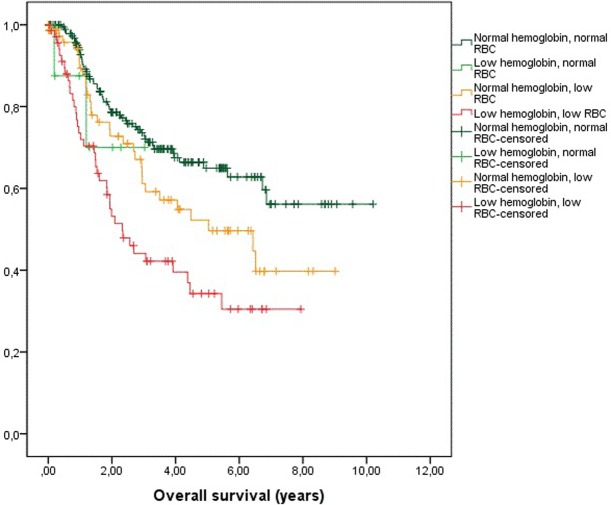
Kaplan-Meier-plots of overall survival depending on hemoglobin-levels and red blood cell (RBC)-counts.